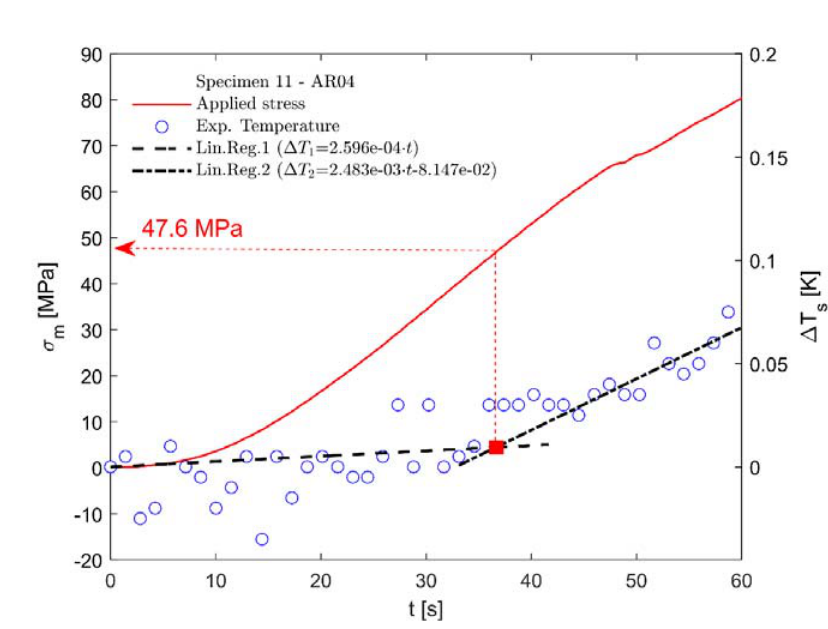
Figure 10:  T vs time curve (blue points) and stress vs time curve (red line) for area AR04 of Specimen 11.